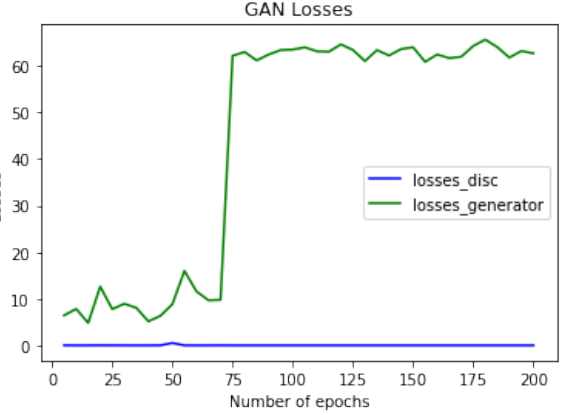
Figure 15. Losses record for the RGB arrangement. Mode collapse can be observed after epoch 75.